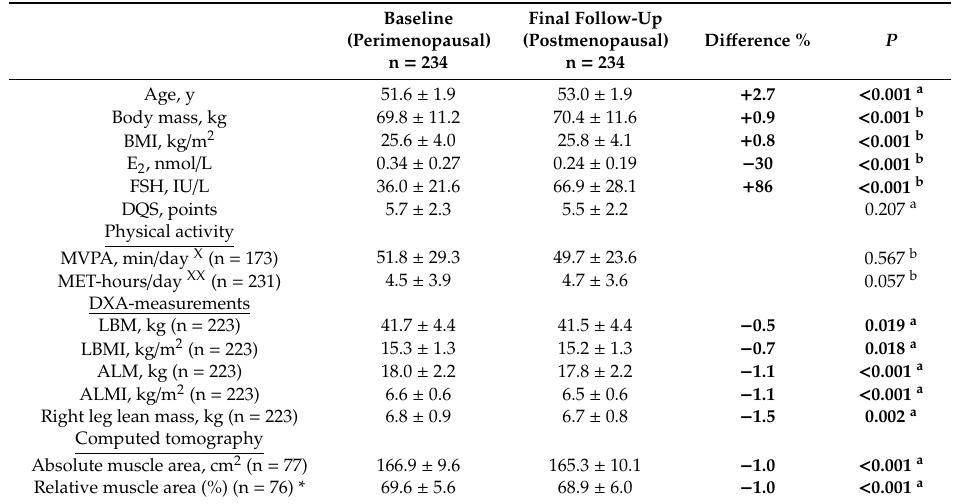
Table 3. Characteristics and lean and muscle mass at baseline and final follow-up (n = 234).